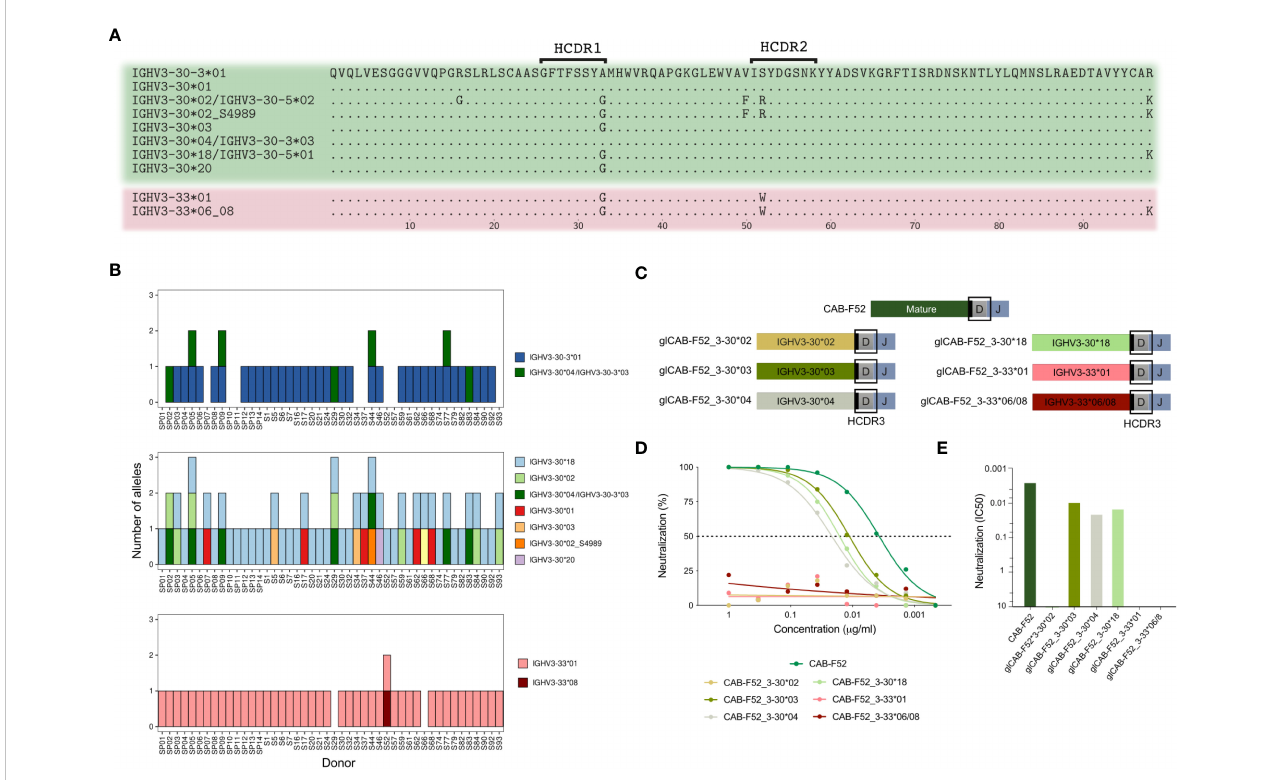
FIGURE 4 IGHV3-30 group of genes are highly variable and can impact CAB-F52 function. (A) Alignment of all the amino acid sequences of IGHV3-30, IGHV3-30- 3 and IGHV3-33 alleles present in the extended group of 46 cases. (B) Allelic content in the 46 cases: IGHV3-30 (top graph), IGHV3-30-3 (middle graph) and IGHV3-33 (lower graph). The IGHV3-30*04/IGHV3-30-3*03 (dark green) is shown in both the IGHV3-30-3 and IGHV3-30 plots since they cannot be distinguished (C) Cartoons showing the design of the germline-reverted CAB-F52 HC variants. (D) Titration curves showing percentage neutralization of the allele-swapped CAB-F52 mAb variants. (E) IC50 neutralization values of the allele-swapped CAB-F52 mAb